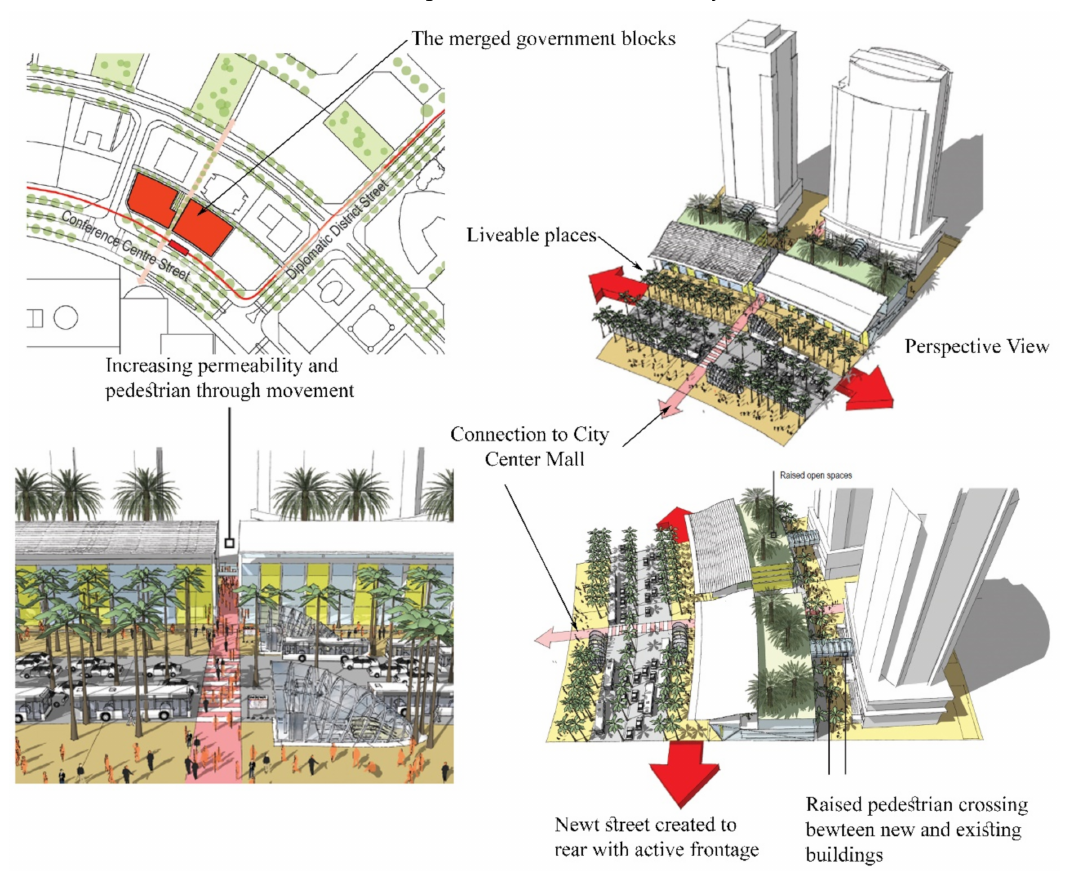
Figure 14. Retrofitting the Block